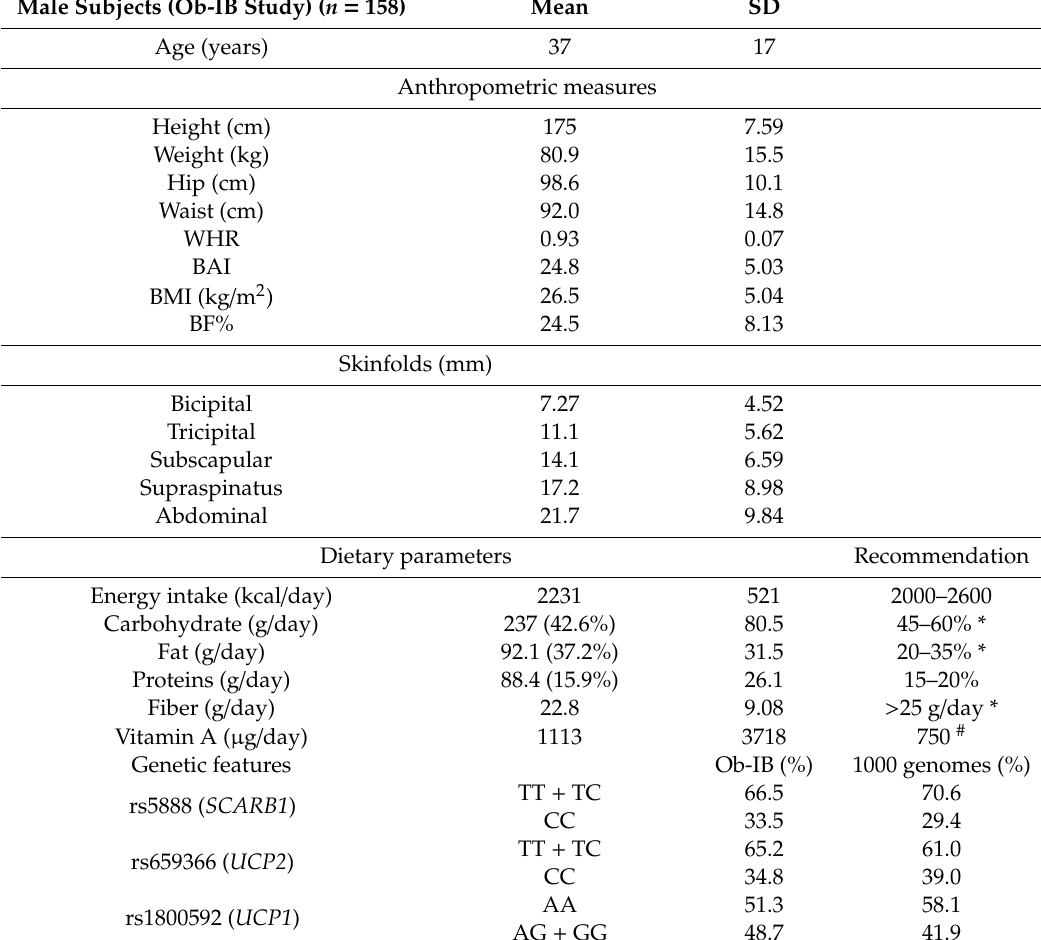
Table 1. General anthropometric dietary and genetic characteristics of male Ob-IB study participants 1 . Male Subjects (Ob-IB Study) ( n = 158)